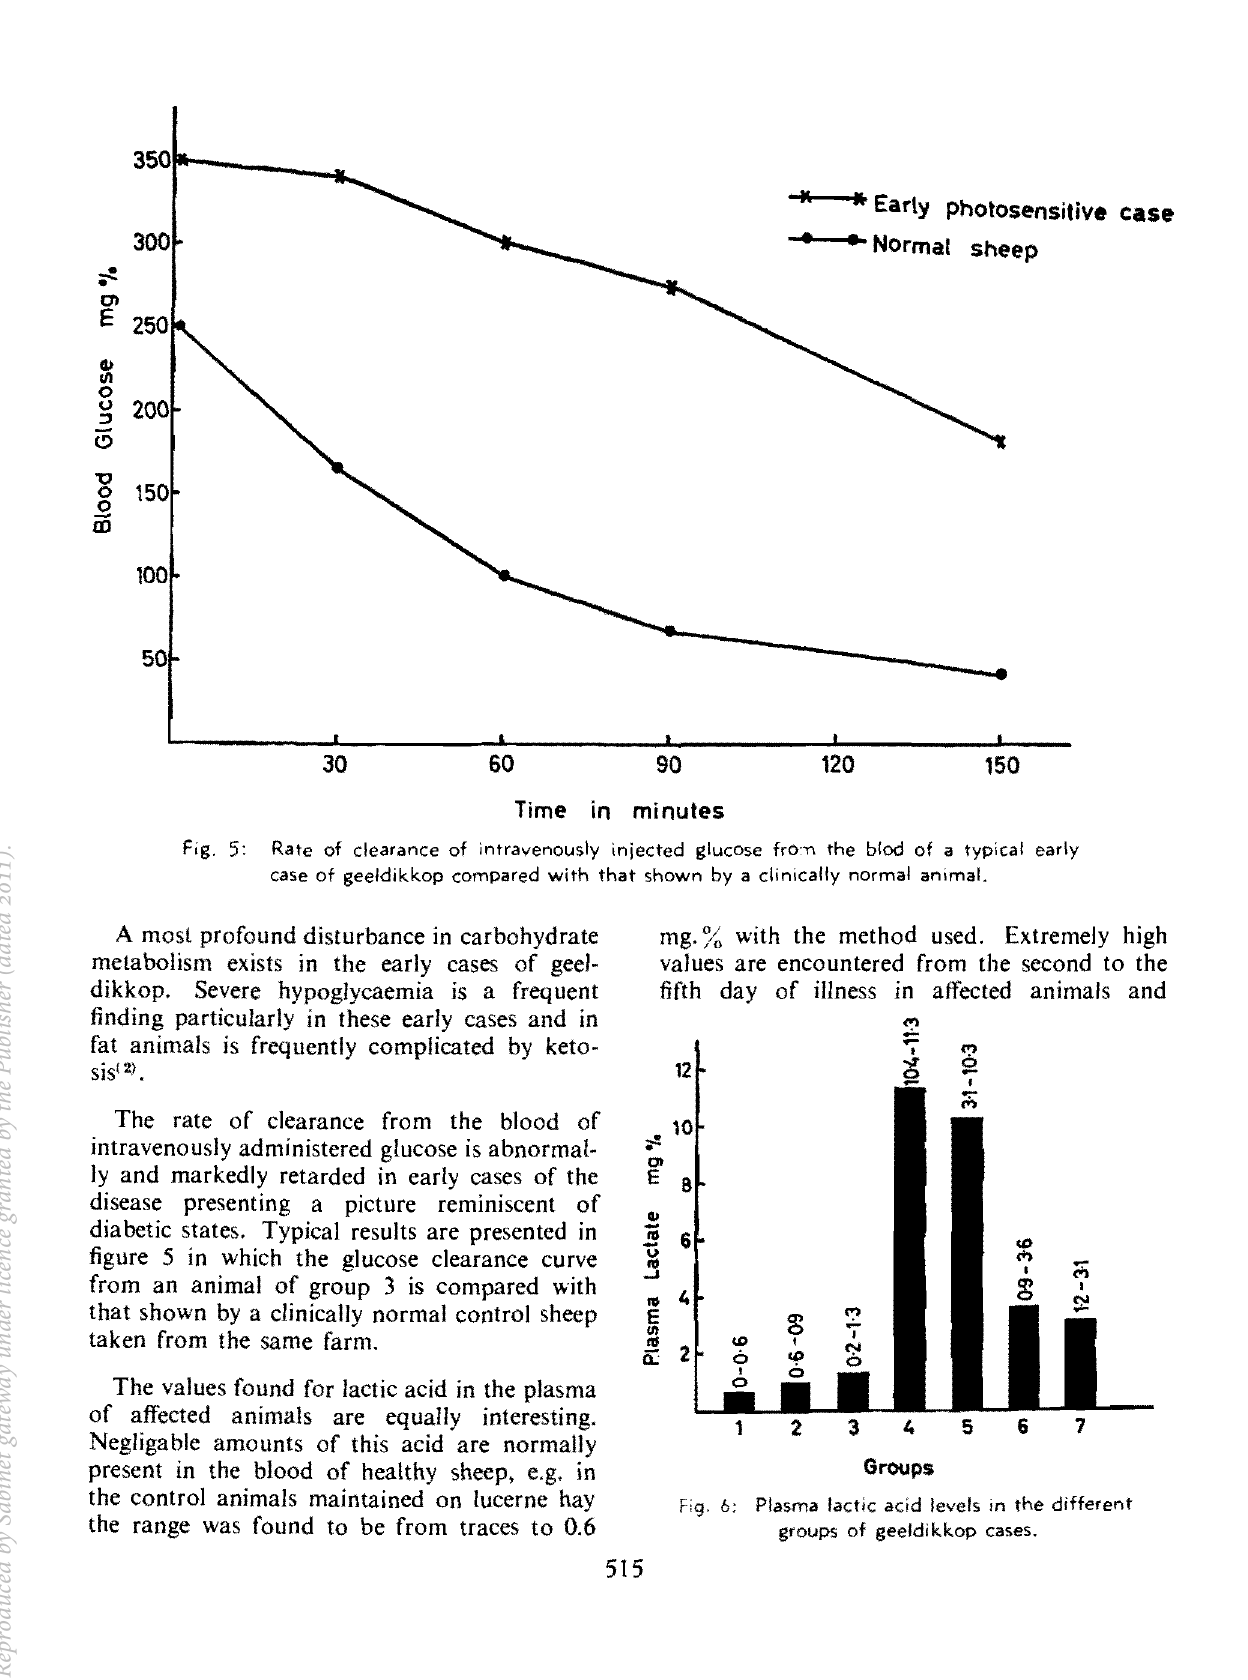
Fig. 6; Plasma lactic acid levels in the different groups of geeldikkop